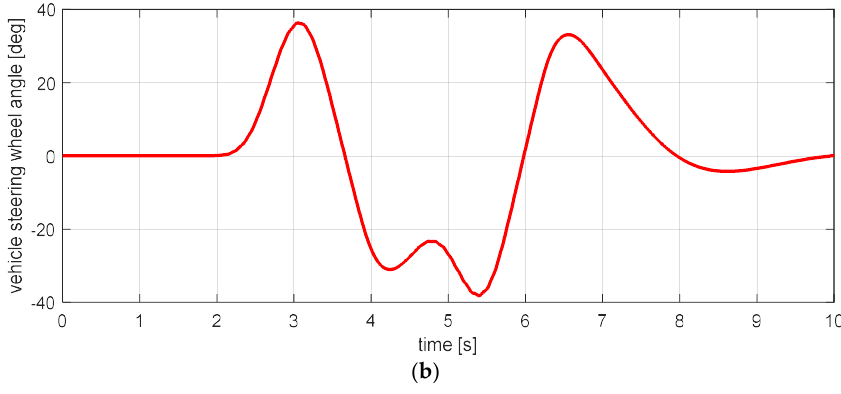
Figure 9. Estimation simulation scenario 2. ( a ) Vehicle speed; ( b ) vehicle steering wheel angle.